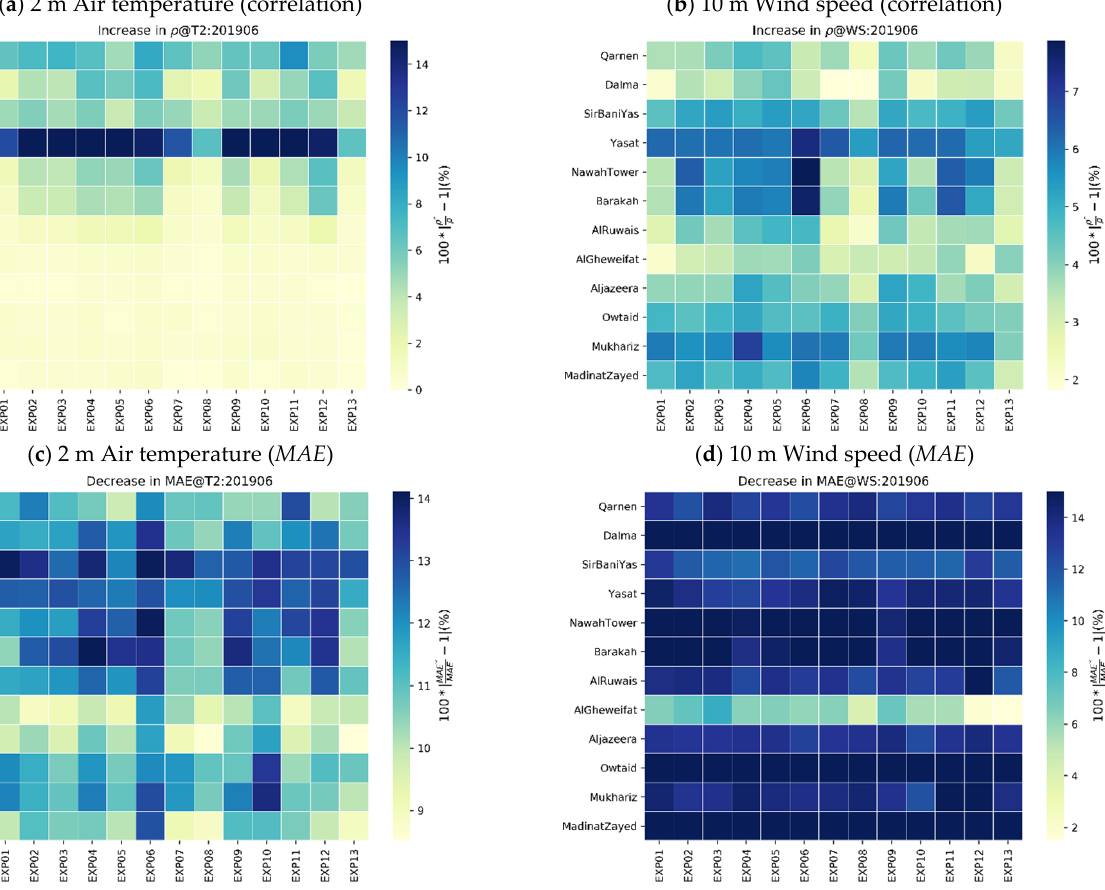
Figure 5. Impact of dynamic initialization through station nudging on model-to-observations statis- tics. ( a , b ) represent respectively the increase in the correlation for 2 m air temperature and 10 m wind speed; ( c , d ) depict the decrease in the mean absolute error for the same two surface parame- ters.